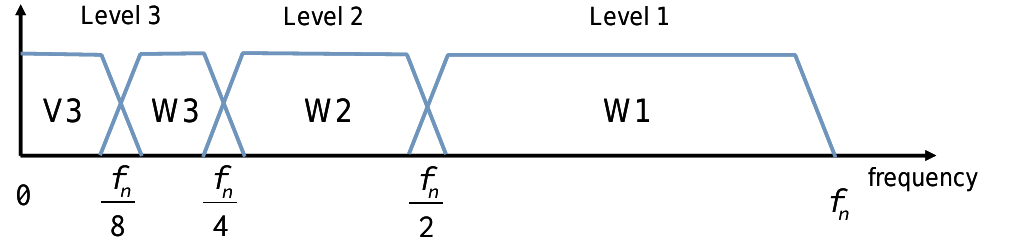
—upper limit in the n